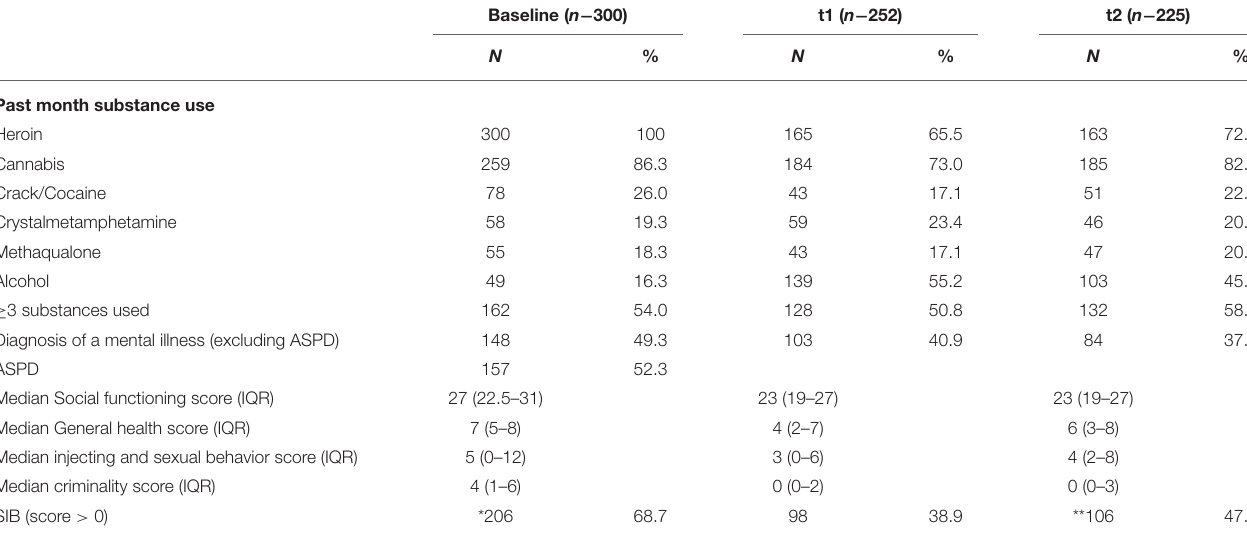
TABLE 1 | Clinical characteristics over 9-months.